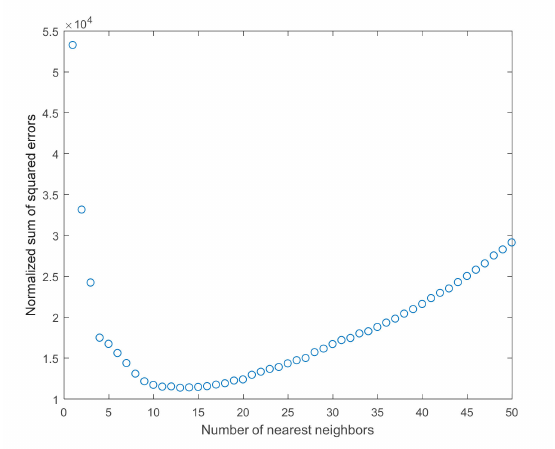
Figure 8. Mean square error (MSE) at di ff erent K values.